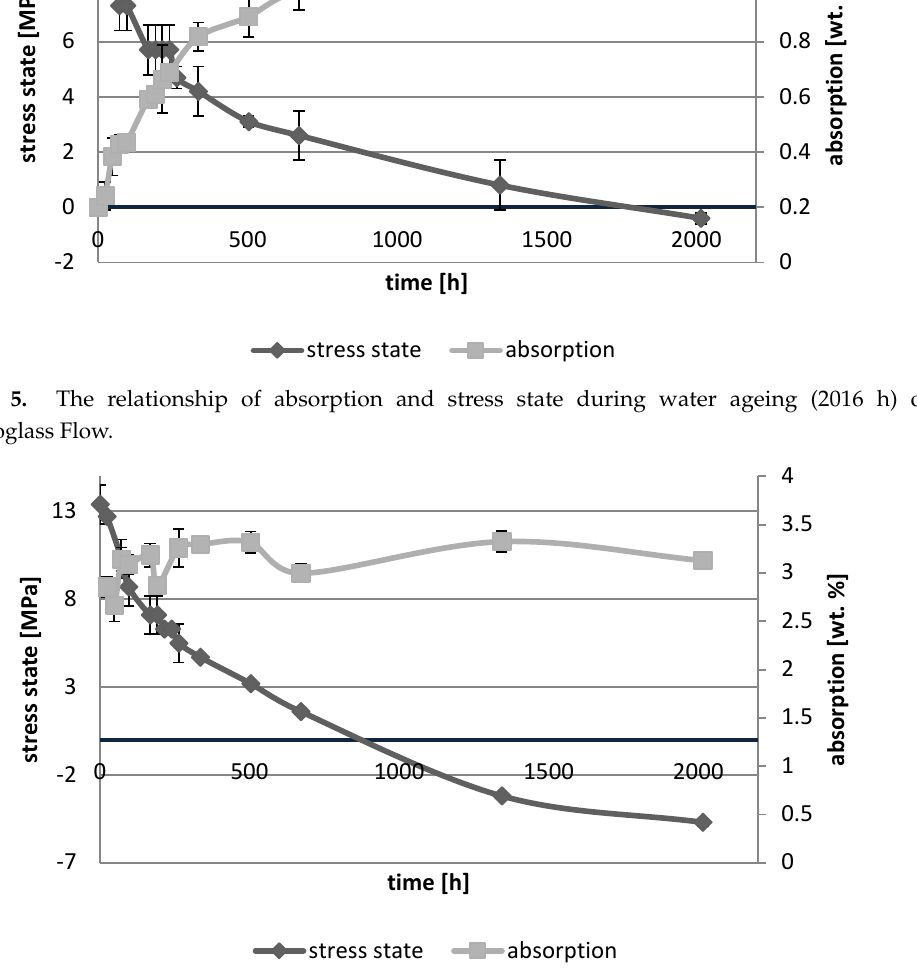
Figure 6. The relationship of absorption and stress state during water ageing (2016 h) of Ionosit.